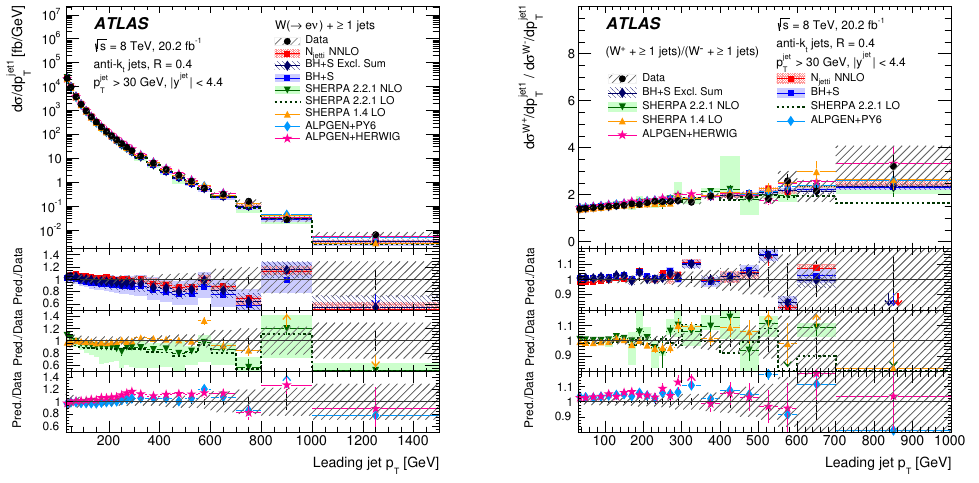
Figure 5 . Di(cid:11)erential cross sections for the production of W bosons (left) and the W + =W (cid:0) ratio (right) as a function of the leading jet p T for events with N jets (cid:21) 1. The last bin in the left (cid:12)gure includes values beyond the shown range. For the data, the statistical uncertainties are indicated as vertical bars, and the combined statistical and systematic uncertainties are shown by the hatched bands. The uppermost panel in each plot shows the di(cid:11)erential cross sections, while the lower panels show the ratios of the predictions to the data. The theoretical uncertainties on the predictions are described in the text. The arrows on the lower panels indicate points that are outside the displayed